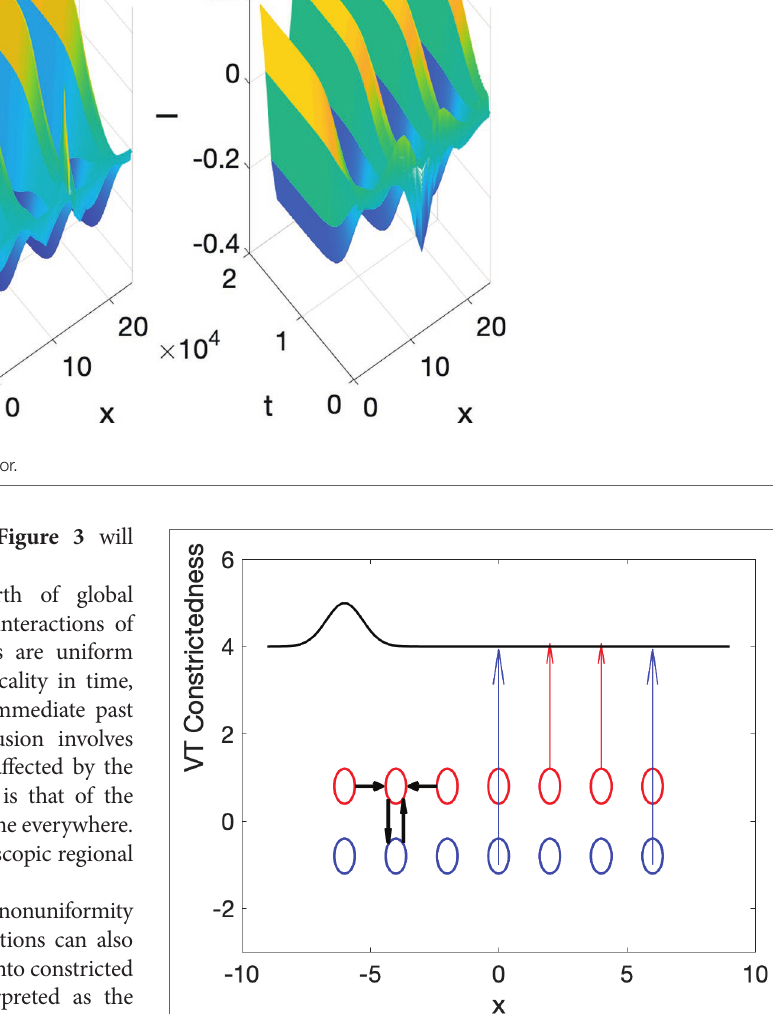
FIGURE 4 | Model of constriction formation with a reaction-diffusion